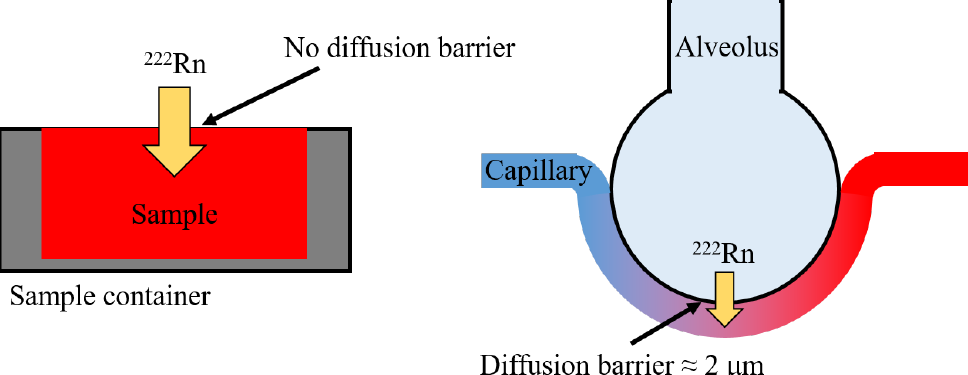
Figure 4. Schematic drawing of exposure scenarios. Left side shows in vitro sample exposure with no diffusion barrier, as performed in this study; right side shows in vivo diffusion within lungs with a diffusion barrier of around 2 μm , as seen in animal studies.